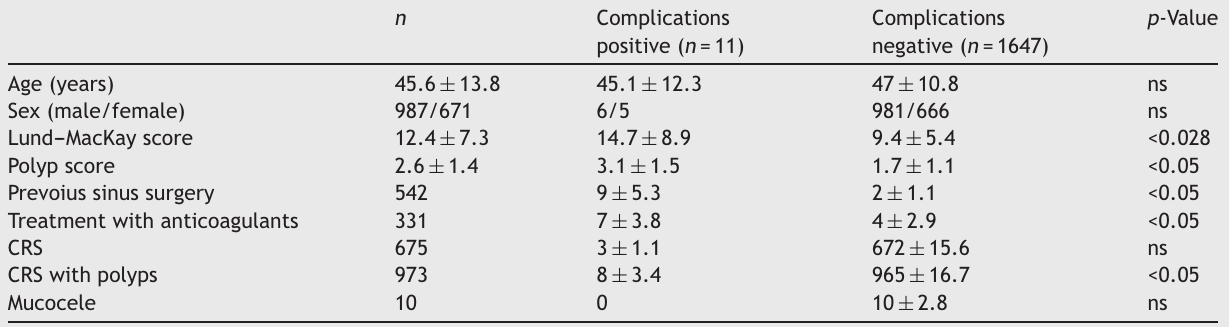
Pathophysiological findings and complications rate.